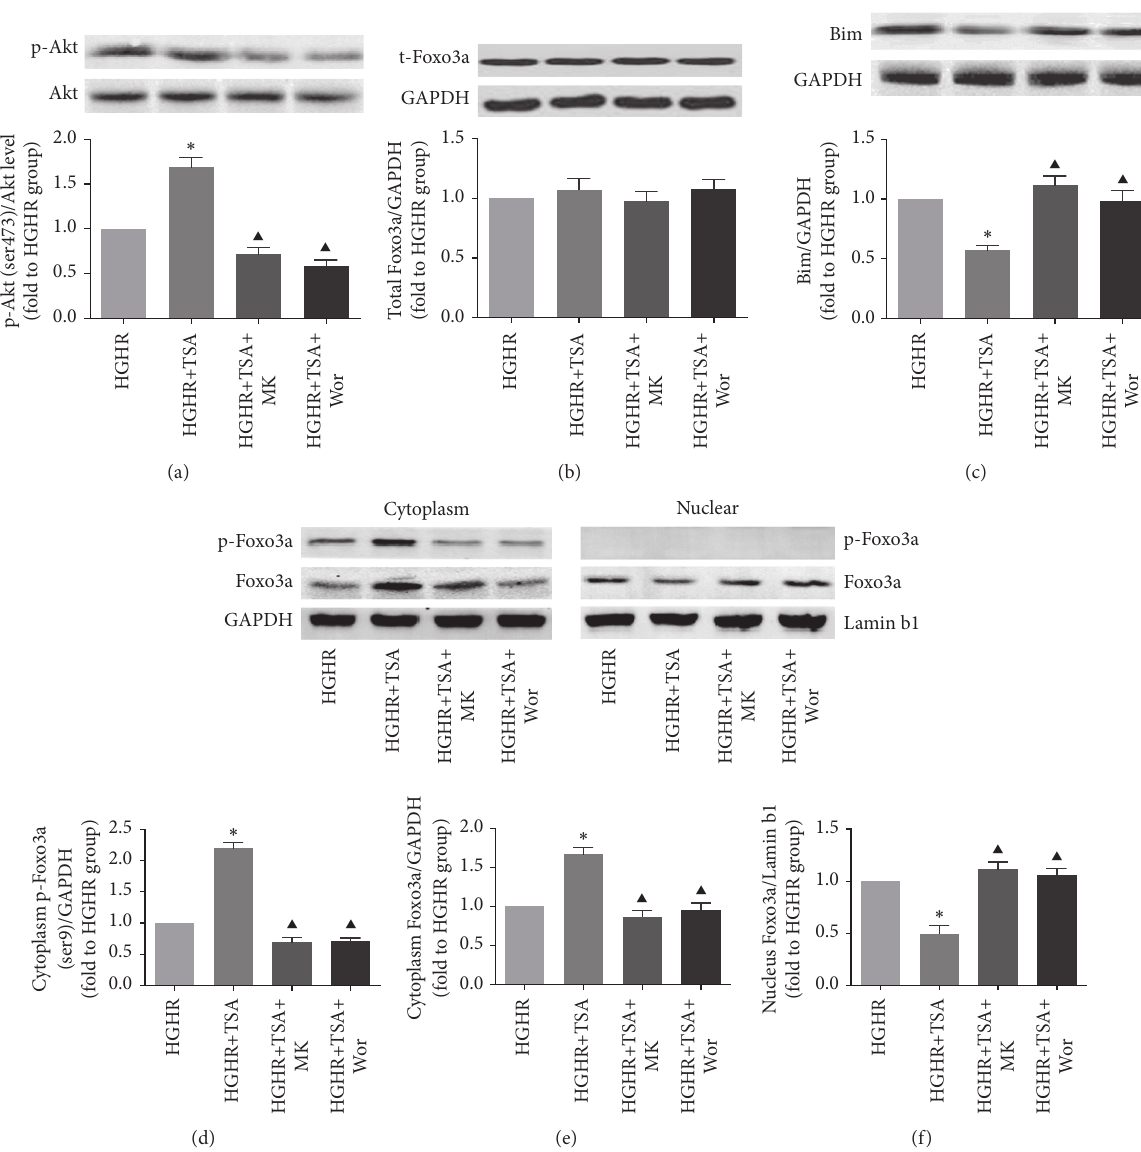
of Foxo3a may lead to nuclear exclusion and cytoplasm